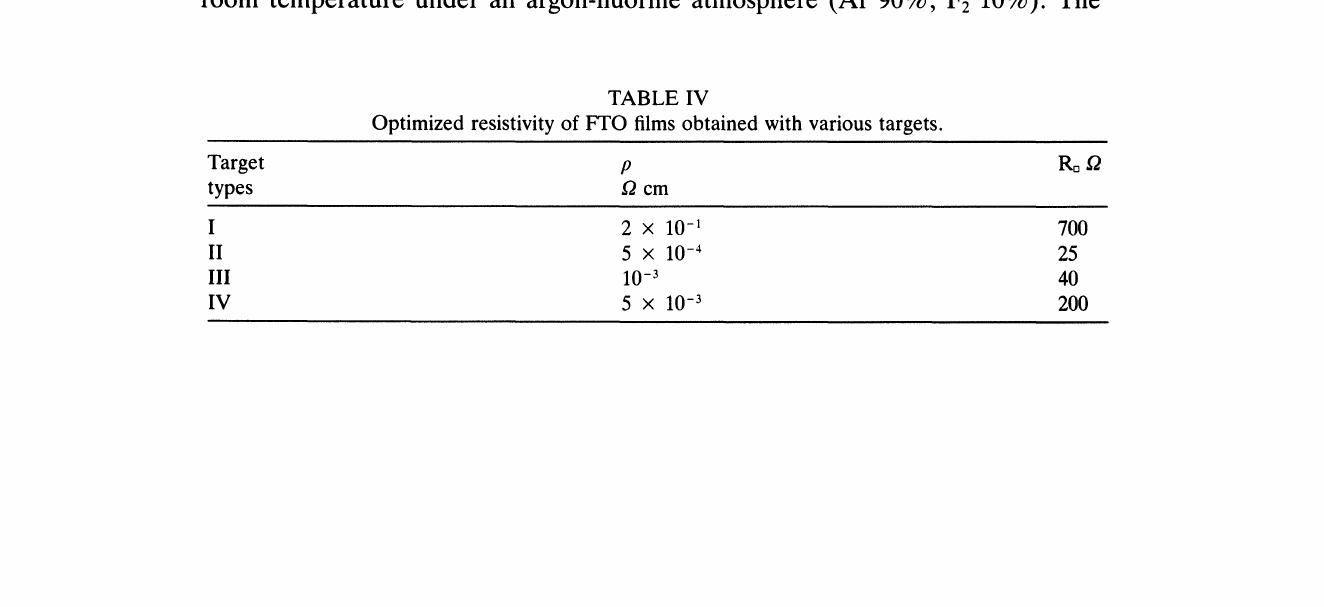
Optimized resistivity of FTO films obtained with various